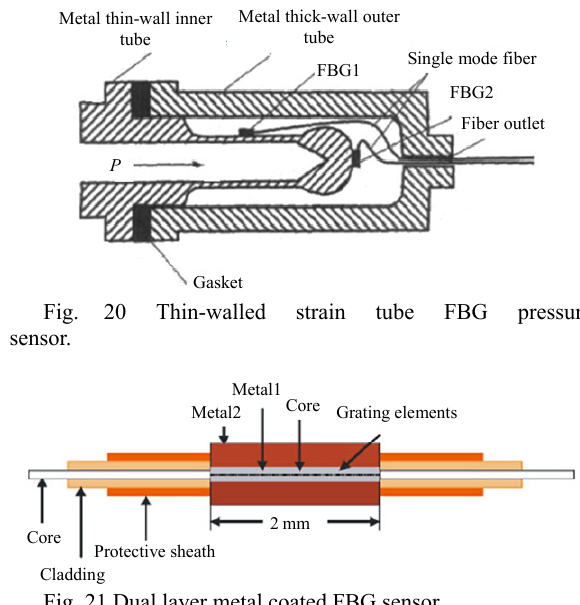
Fig. 21 Dual layer metal coated FBG